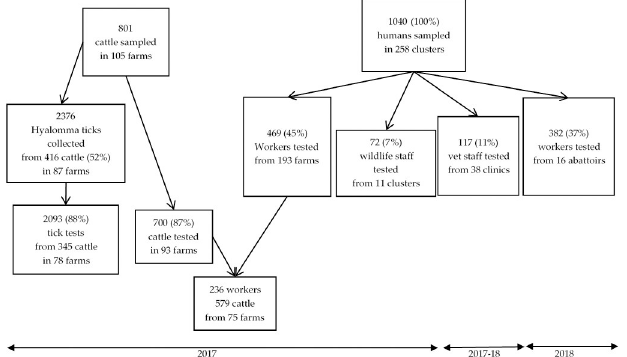
Fig 2. Sampling and testing of humans, cattle and ticks for Crimean-Congo haemorrhagic fever virus antibodies or RNA, central South Africa,